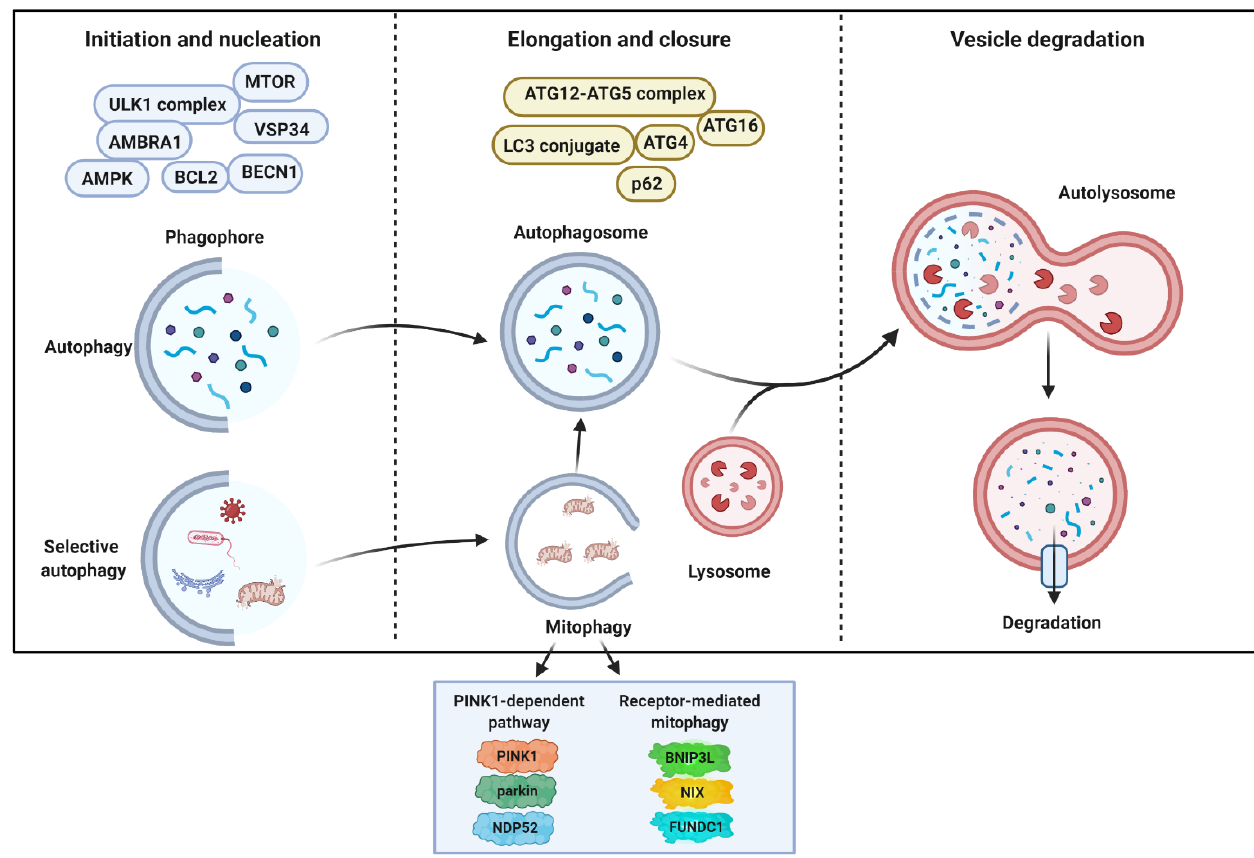
Figure 1. Molecular aspects of autophagy. Autophagy is a catabolic process used by eukaryotic cells to maintain cellular homeostasis and cellular and organellar quality control in response to multiple forms of stress. Different factors are involved during the main stages of autophagy. During the initiation step, the Unc-51-like kinase 1 (ULK1) serine threonine kinase complex receives input from the mechanistic target of rapamycin (MTOR) and from the kinase 5 (cid:48) AMP-activated protein kinase (AMPK). Meanwhile, MTOR is the main autophagic repressor; AMPK is an autophagy activator. The ULK1 complex then activates nucleation of the phagophore by activating members of class III phosphatidylinositol 3 kinase (PI3KC3) complexes, such as AMBRA1, VSP34, and BECN1. BCL2 regulates the activity of BECN1. Ubiquitin-like conjugation systems ATG12-ATG5-ATG16 and LC3-ATG4 are necessary for the maturation of the vesicle. Other proteins, such as p62, complete the autophagosome formation. The last phase is characterized by fusion of the autophagosome with lysosome and the degradation of the autophagic cargo by acidic hydrolases.